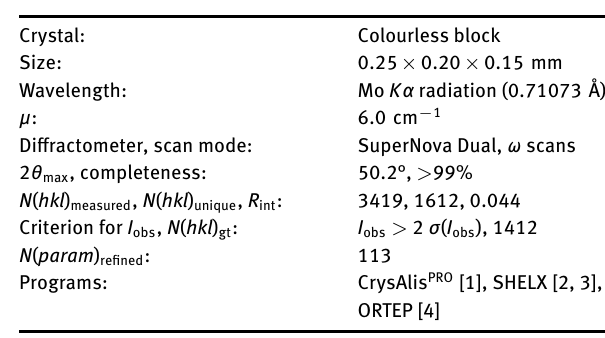
Table 1: Data collection and handling.